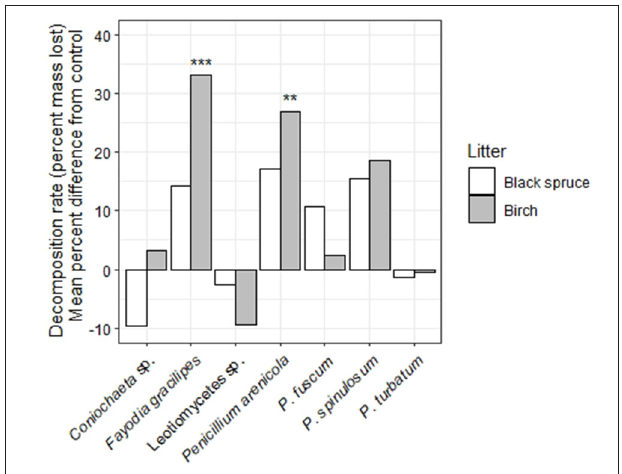
FIGURE 3 | Saprotrophic activity of seven heat-resistant fungal taxa, as measured by decomposition rates measured as mass lost of black spruce (white bars) and birch (gray bars) litter over 10 wks incubation in controlled conditions. Results are presented as the mean percent difference for each fungal treatment from the uninoculated control treatment, from 999 bootstrap samples. Values above zero indicate greater decomposition in inoculated samples relative to the control treatment. Asterisks indicate significant effects of inoculation relative to the control treatment based from linear models (** P < 0.01; *** P < 0.001; Table S3